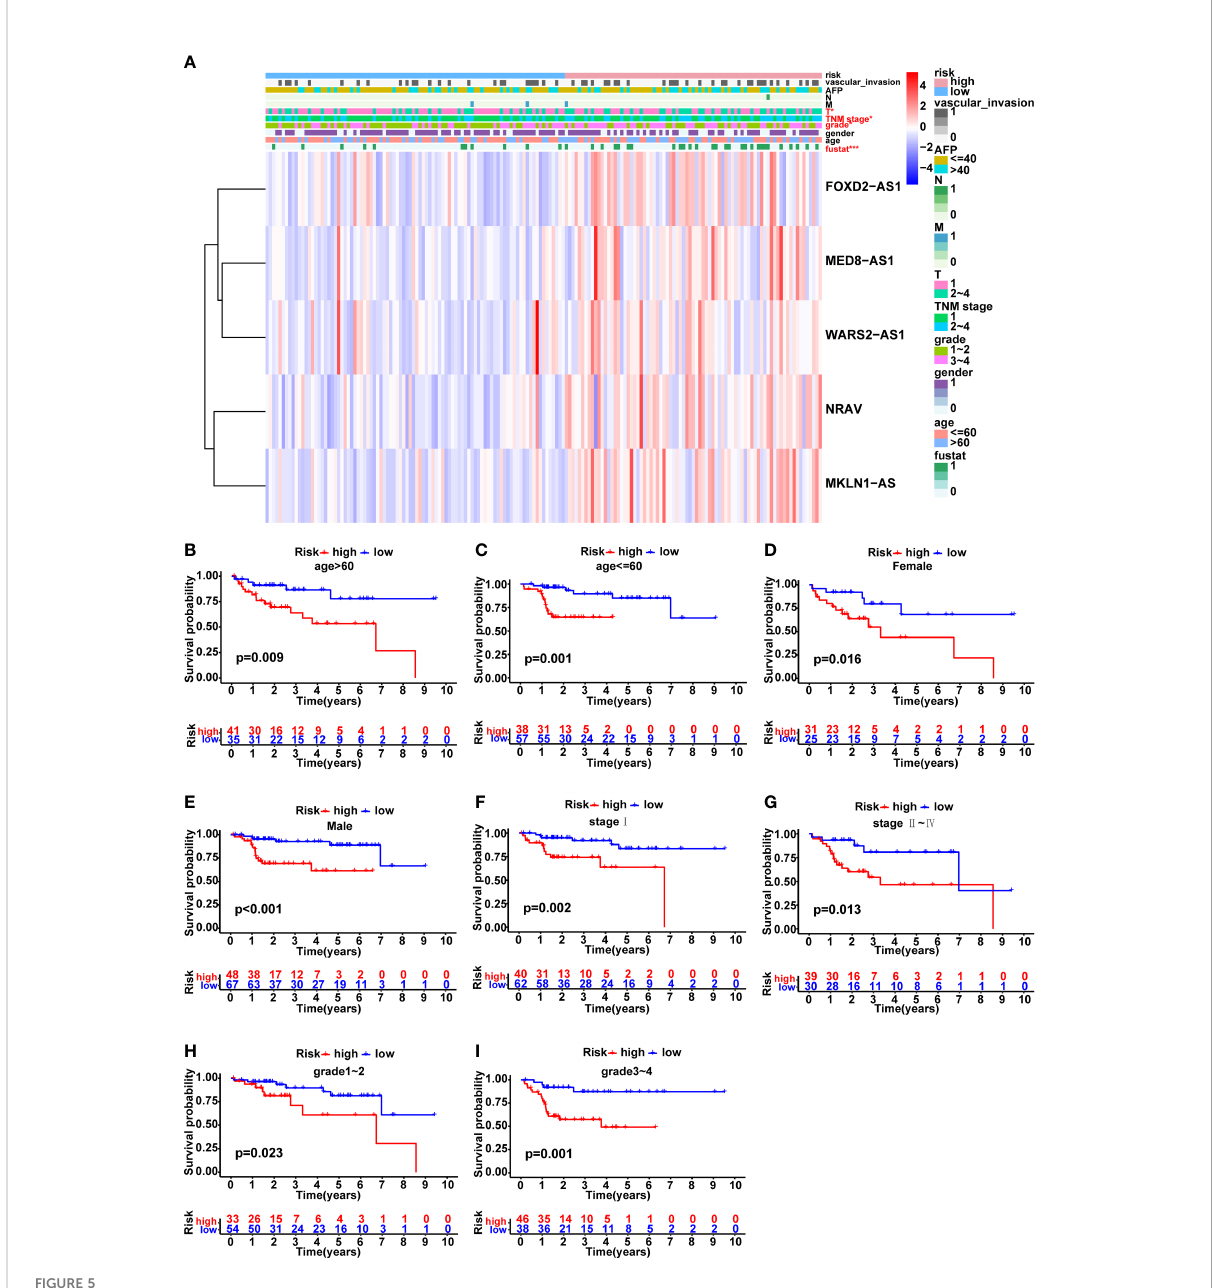
FIGURE 5 Correlation analysis between the prognostic signature and different clinicopathological characteristics in the TCGA cohort. (A) The heatmap illustrating the distribution of ten distinct clinicopathological features, together with the risk score for each patient based on the predictive signature. Clinicopathological features in red indicated that there was an obvious difference distributed in the high- and low-risk group. (B-I) Kaplan-Meier survival curves for high-risk and low-risk patient groups based on age, gender, TNM stage and grade classi fi cation. *p < 0.05, and ***p <